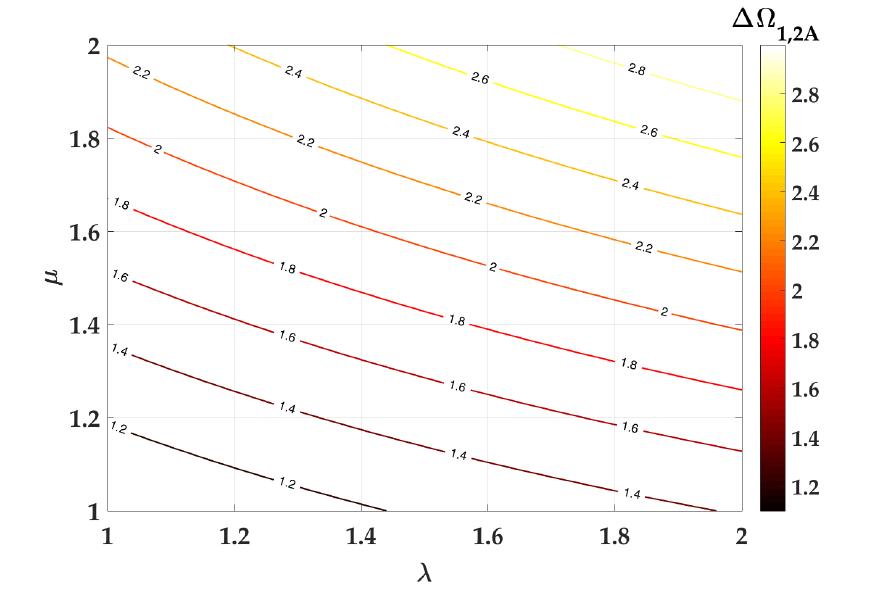
Figure 3. Contour plot of difference in first two dimensionless eigenfrequencies ( ∆Ω 1,2 A ) with respect to ratio of beam masses ( µ ) and their respective first eigenfrequencies ( λ ) acquired from Equation